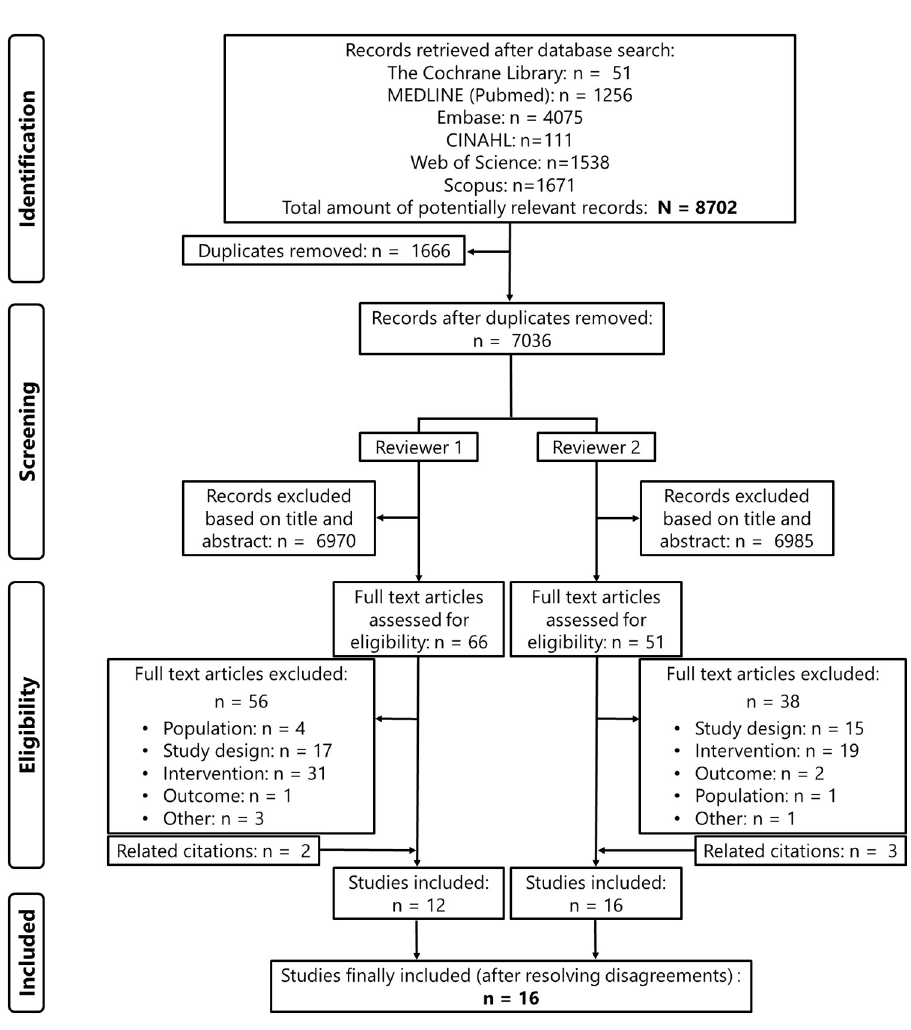
Fig 1. Study identification and selection process of the systematic